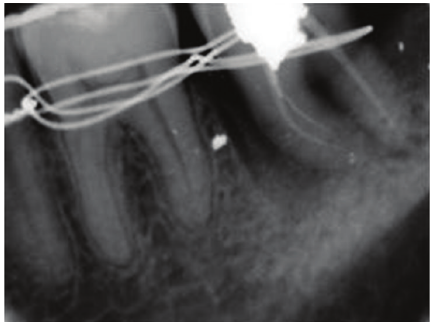
Figure 3: After transplantation and splinting.